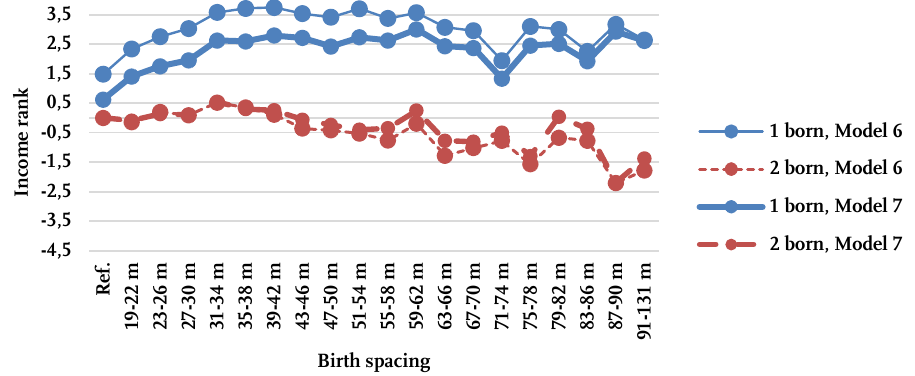
Panel E: Estimates from models 6 and 7,